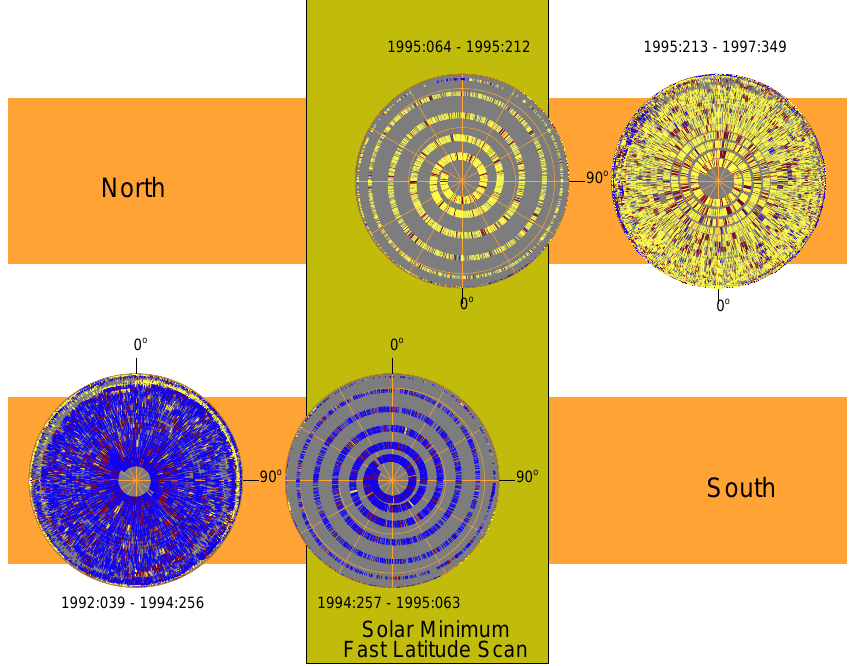
Fig. 3. The same data as presented in the first two and a half panels of Fig. 2, but projected onto spheres representing the solar wind source surface, viewed from above the solar rotational poles. Time broadly moves from left to right, with the Northern Hemisphere shown in the upper plots, and the Southern Hemisphere in the lower plots. Carrington longitudes of 0 ◦ and 90 ◦ are indicated. The colours denote the same polarities as defined in Fig.